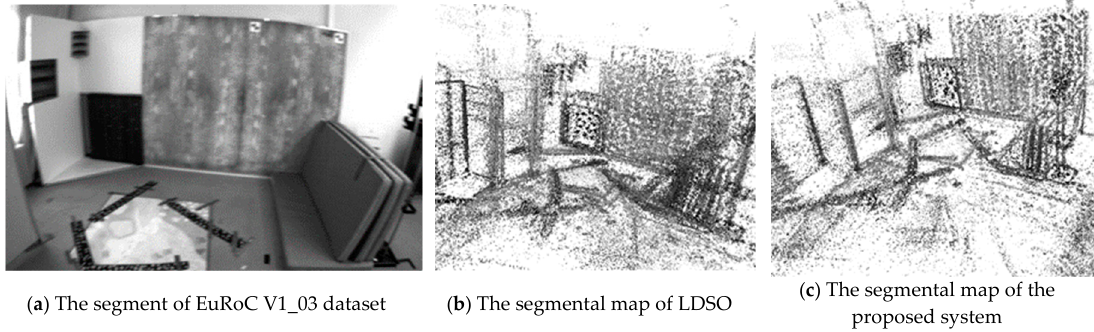
Figure 15. The segmental experimental results of LDSO and proposed system on the EuRoC dataset, V1_03_difficult sequence.